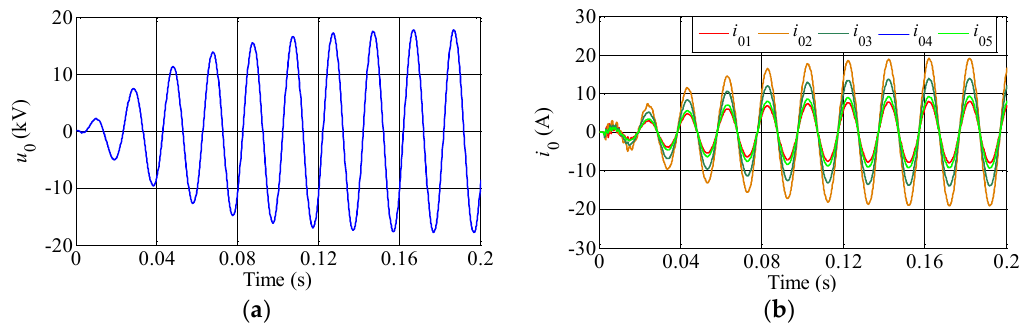
Figure 6. Bus zero-sequence voltage and zero-sequence current of each feeder for a single-phase HIF in K4 point. ( a ) Bus zero-sequence voltage; and ( b ) Feeders’ zero-sequence currents.